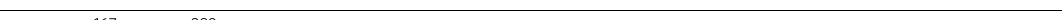
Fig. 5 The Arg 167 and Cys 289 residues are involved in Hcy-induced AT1 receptor activation. a Binding structures predicted in the global docking stage. b Binding mode of the AT1 receptor in cluster 3. Hcy is shown in green. Amino acid residues involved in ZD7155 binding are shown in gray. c Schematic diagram of the AT1 receptor Arg 167 mutation. d The speci fi c binding of [ 125 I]-Ang II and the WT AT1 receptor vs. the R167A-mutated AT1 receptor with different competing concentrations of Hcy. The data represent as mean ± SEM, N = 6. e Ang II (1 μ M)- or Hcy (100 μ M)-induced NFAT signaling in HEK293A cells transfected with the R167A-mutated AT1 receptor, detected by the dual-luciferase assay system (Promega). The data represent as mean ± SEM, N = 6, * P < 0.05, two-way ANOVA followed by the Bonferroni post hoc test. f , g The measurements of intermolecular Δ net BRET of AT1R and β